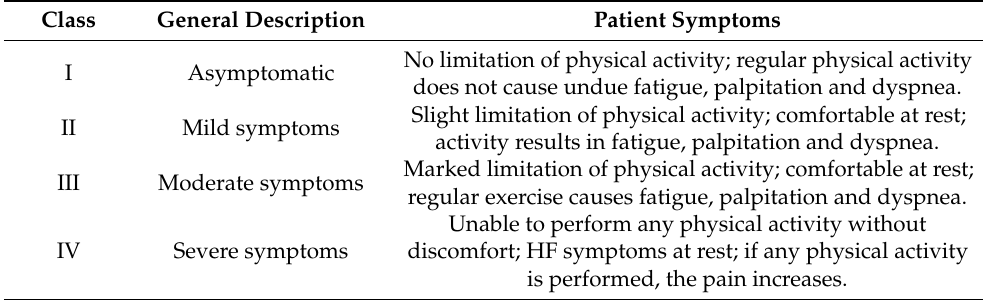
Table 2. New York Heart Association (NYHA) classification of heart failure based on symptoms and level of tolerated physical